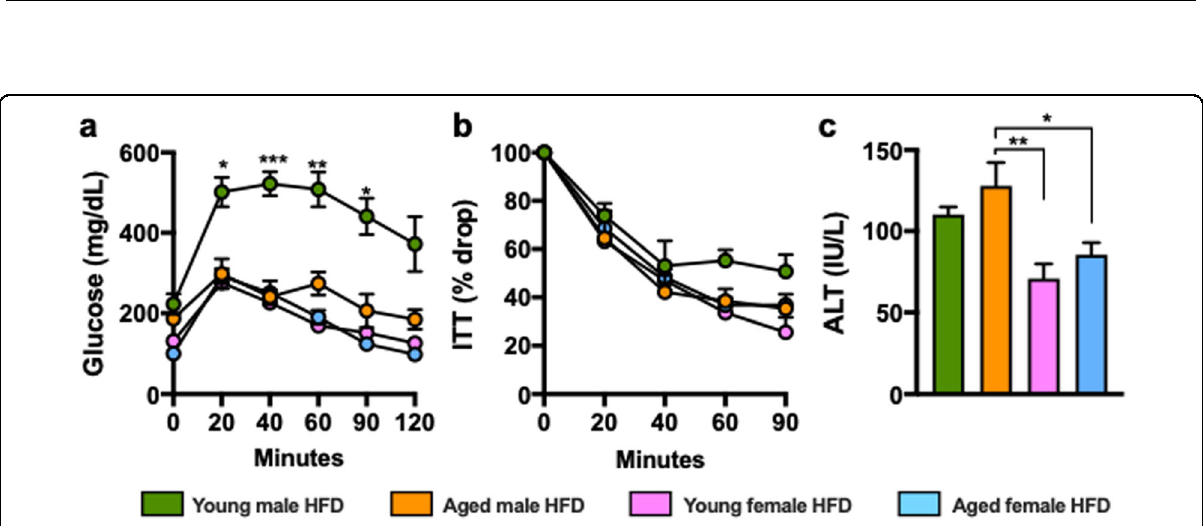
Fig. 3 Gender impacts aging-driven effect on metabolic derangement severity. Comparison of data depicted in Figs. 1 and 2. a Glucose tolerance test (GTT). b Insulin tolerance test (ITT). c Serum Alanine transaminase (ALT)